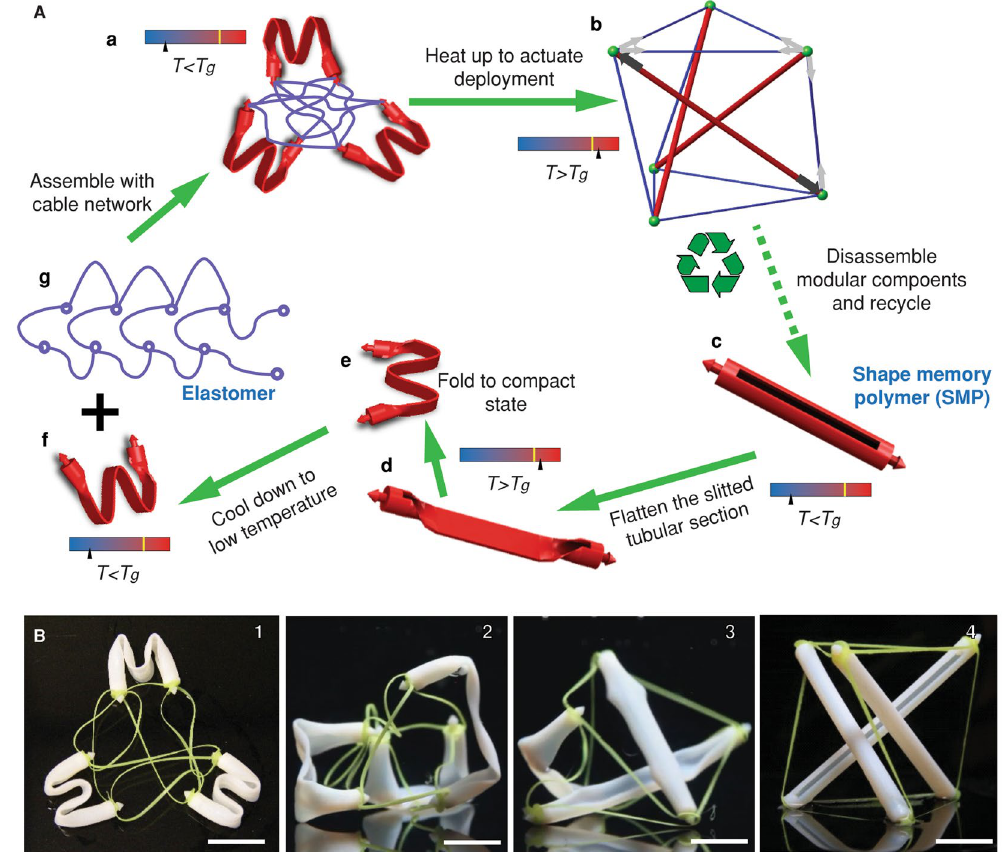
Figure 1. Procedure for creating an active tensegrity. Deployment of an active tensegrity is based on the shape recovery property of shape memory polymers (SMP). ( A ) Schematic of the overall concept and design. (a) The struts, which are programmed to compact shapes, are connected by a network of elastomer cables. (b) Upon heating, the recovery of the struts to their straight shapes leads to actuation of the structure to a 3D resilient tensegrity structure. To achieve this concept, (c) the struts are designed to have tubular shapes with longitudinal slit portions and are 3D printed using SMPs; (d,e) the SMP struts are folded into compact shapes at a temperature that is above the glass transition temperature ( T g ) of the SMP; (f) decreasing the temperature below T g fixes the struts in the compact shapes, which are then assembled with the elastomer cables (g) according to the topology of the design to form a loose assembly (a); heating the assembly to a temperature above T g leads the struts to their original shapes, and thus the constraints from the cables induce self-stress. As a consequence, a stable tensegrity structure is obtained. ( B ) The experimental result shows the deployment process. The scale bars represent 15